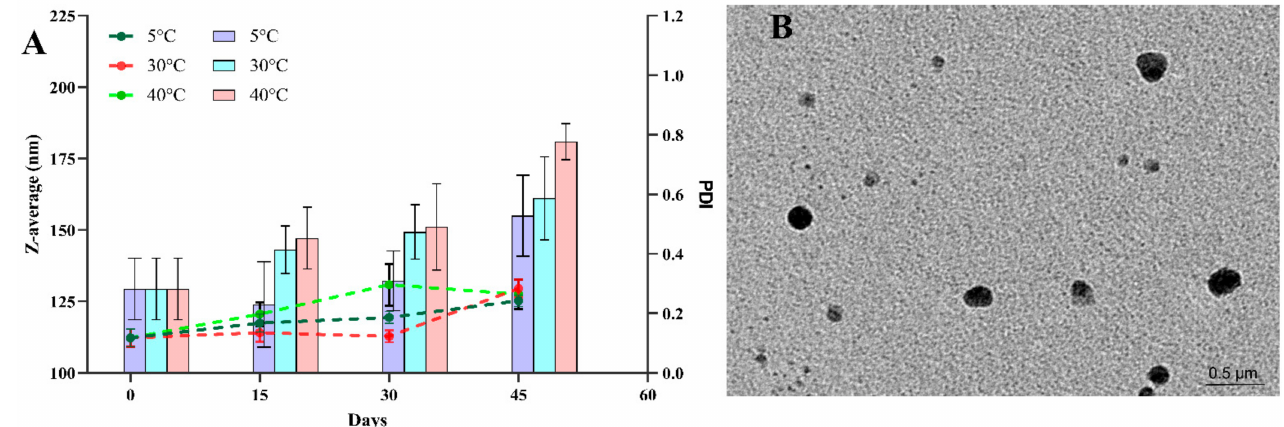
Figure 5. ( A ) Effect of storage temperature on droplet size (Z-average (nm)) and PDI of Que-NE at 5, 30, and 40 ◦ C for 45 days; ( B ) TEM image of optimized